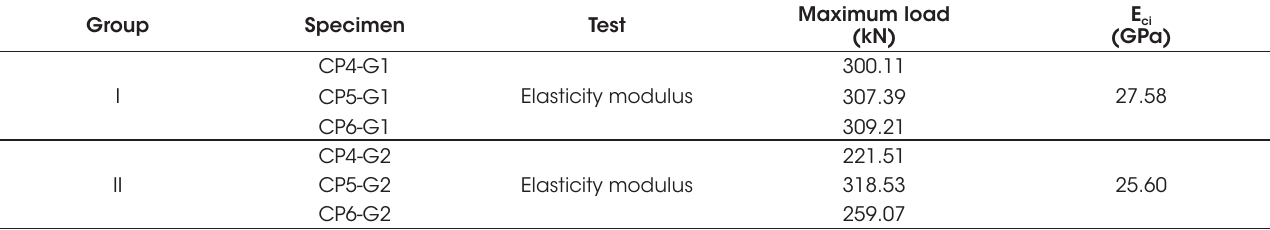
Compressive strength values obtained in elasticity modulus tests Group